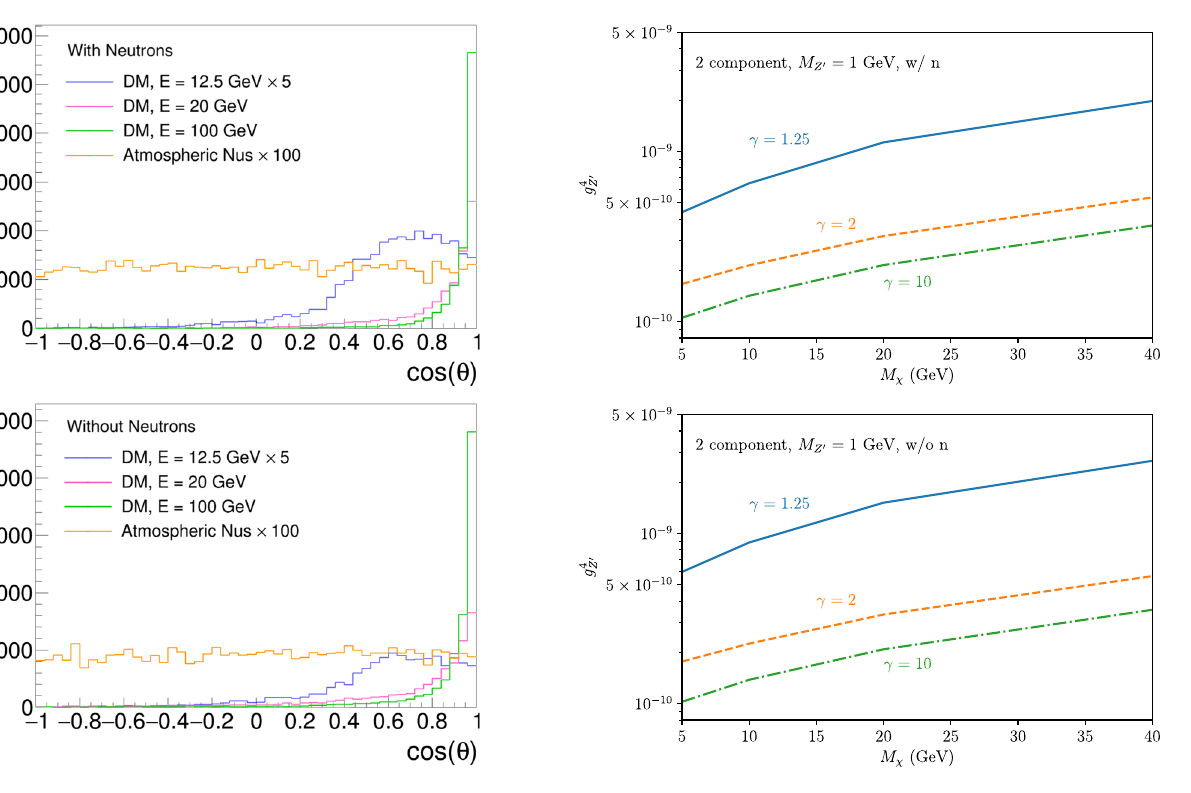
Fig. 26 Expected 5 σ discovery reach with one year of DUNE